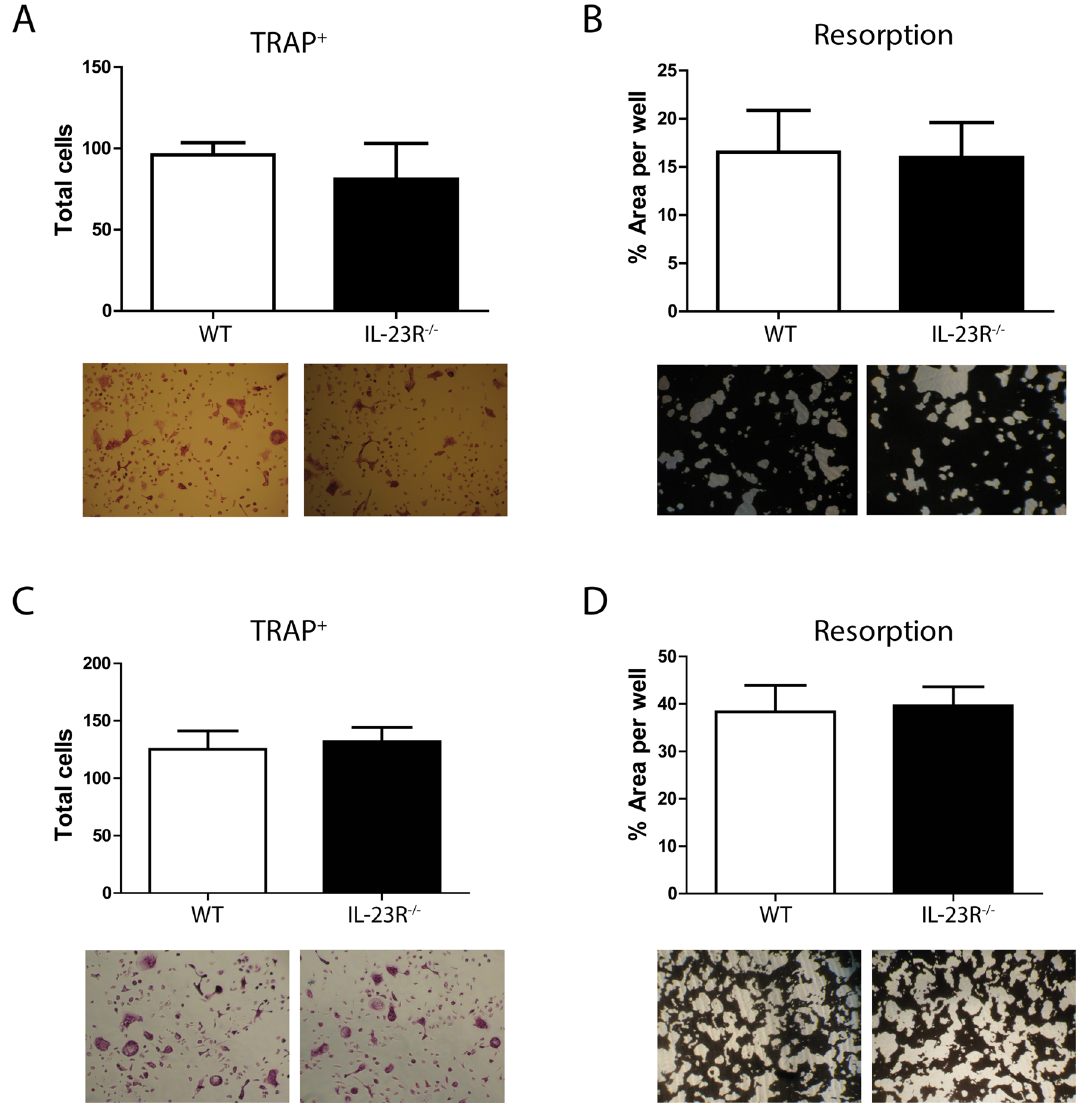
and RANKL. Cells were assessed for osteoclasts at day 5 of culture via TRAP staining. Osteoclast function was assessed at day 7 (12-week-old) or 9 (7-week-old) of culture with resorption assay. ( A ) Trap staining at 7 weeks. ( B ) Bone resorption at 7 weeks. Pooled data of two independent experiments with n = 7 mice per group. ( C ) Trap staining at 12 weeks. ( D ) Bone resorption at 12 weeks. Representative of three independent experiments with n = 3–5 mice per group per